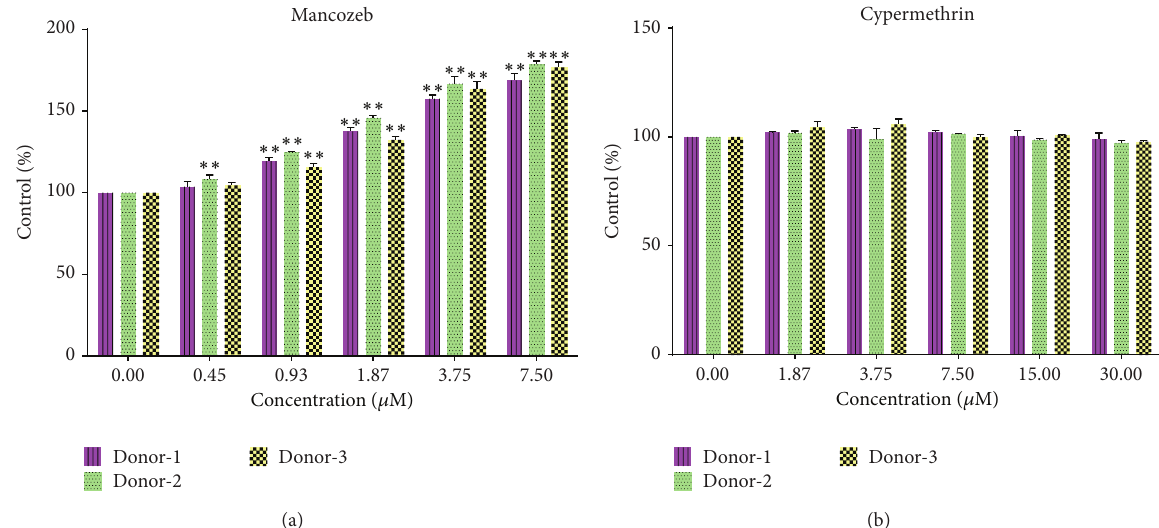
Figure 1: Proliferation-BrdU ELISA assay. Proliferation rate in mitogen (PHA-) stimulated PBMC cultures. (a) Mancozeb; (b) cypermethrin. ∗ 𝑃 < 0.05 ; ∗∗ 𝑃 < 0.01 versus zero control. For each donor, statistical analyses performed across the doses showed that values were consistently significantly different as a function of dose in the mancozeb